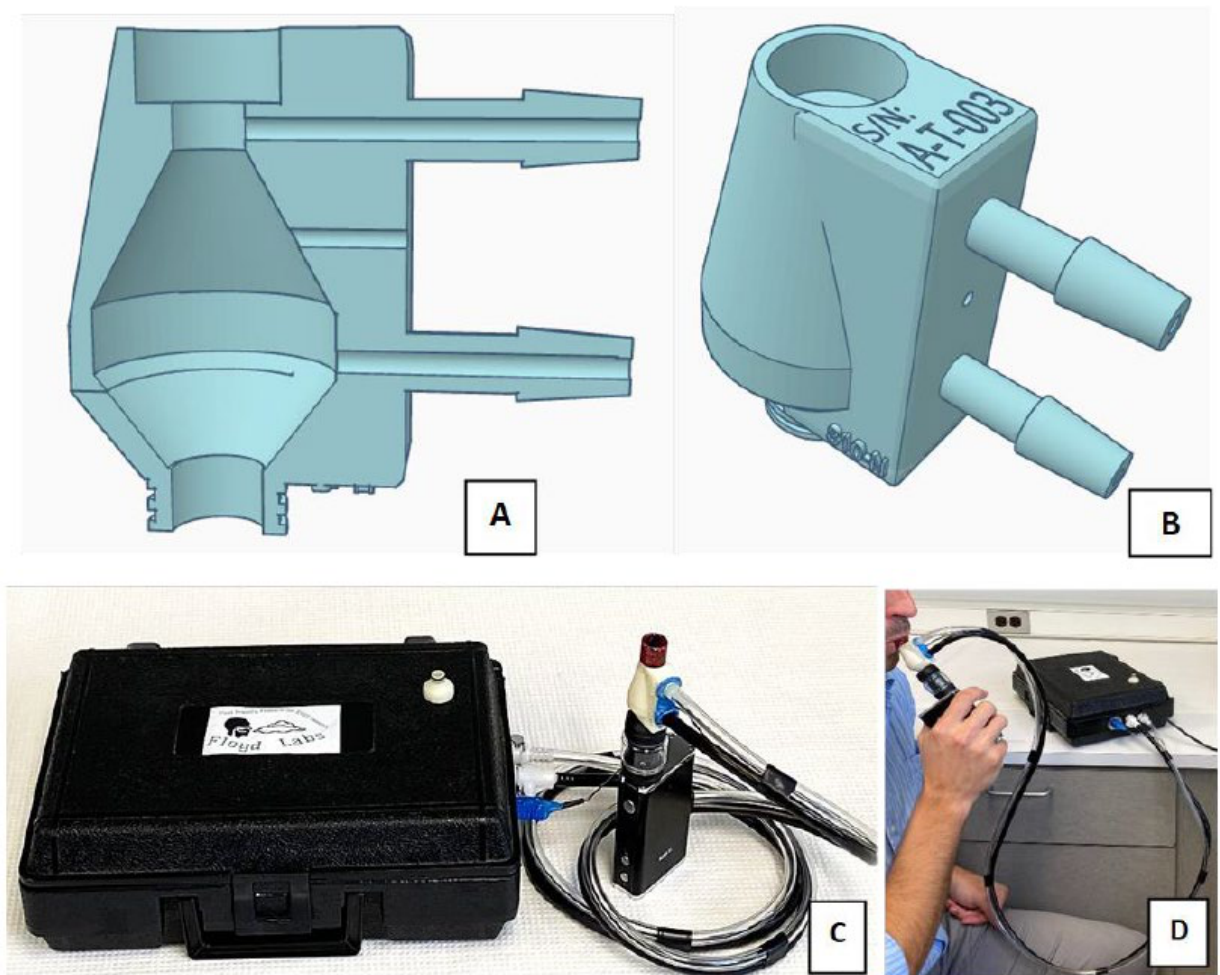
Figure 1. A 3D design of an 810-N puff topography flow cell. Panel ( A ) shows the side profile cut-away of the flow cell with pressure ports located at the constriction and expansion points. Panel ( B ) shows the top socket sized to fit an 810 mouthpiece, and the external view of the device. Panel ( C ) shows the whole topography system connected to an EC device. Panel ( D ) shows the topography device while in use during a simulated puffing session.